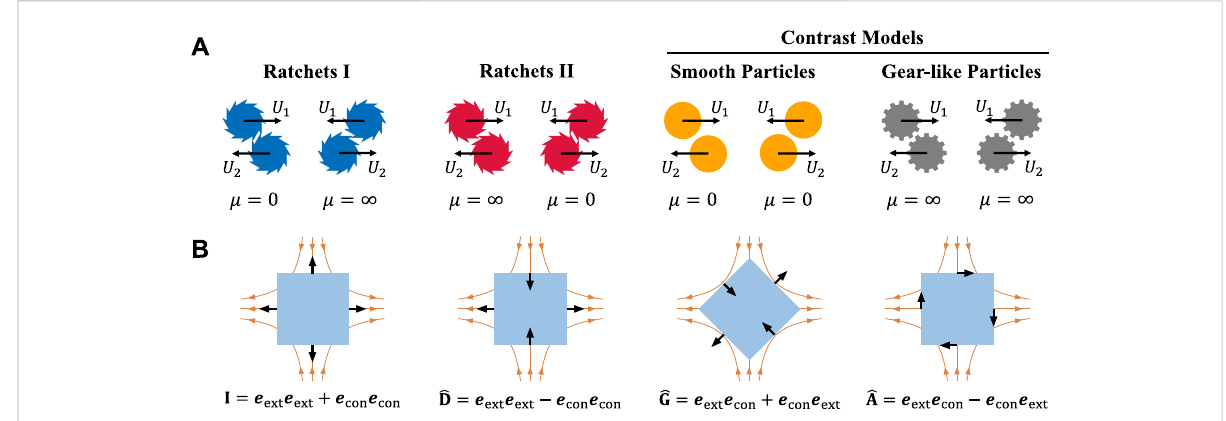
FIGURE 1 (A) Schematic of four particle models: ratchets I (with clockwise teeth), ratchets II (with anticlockwise teeth), smooth particles, and gear-like particles.Whentworatchetstangentiallycontactandtheirteethatthecontactpointareanti-parallelandparalleltotheirrelativevelocity,weassume the contacts are frictionless ( μ = 0) and in fi nitely-frictional ( μ = ∞ ), respectively. The smooth and gear-like particles (for contrast only) experience zeroandin fi nitefriction,respectively. (B) Schematicofstresscomponentsandcorrespondingbasistensors.Theblackarrowsindicatethestress directions, whereas the orange lines and arrows represent the embedded extensional fl ow including the contraction (vertical) and extension (horizontal)